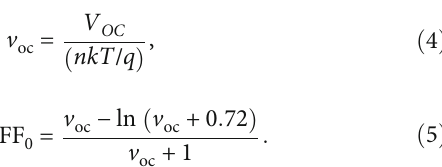
NH PbI SCN x 3 3 3- x